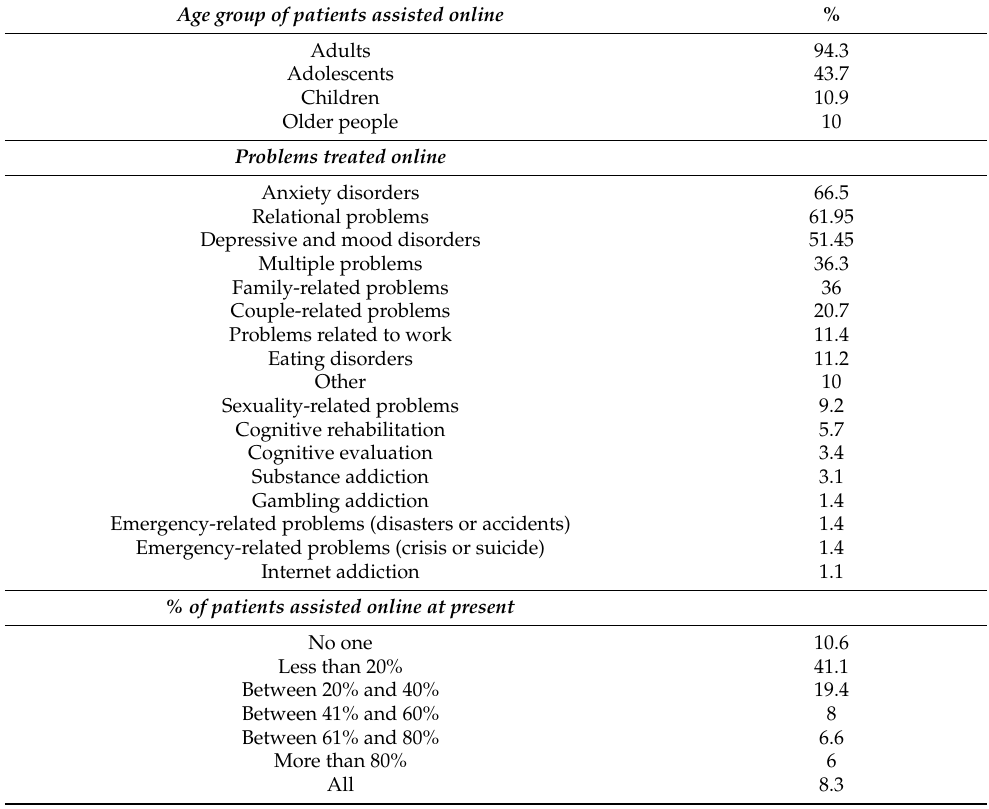
Table 5. Data regarding patients’ assisted online at present.